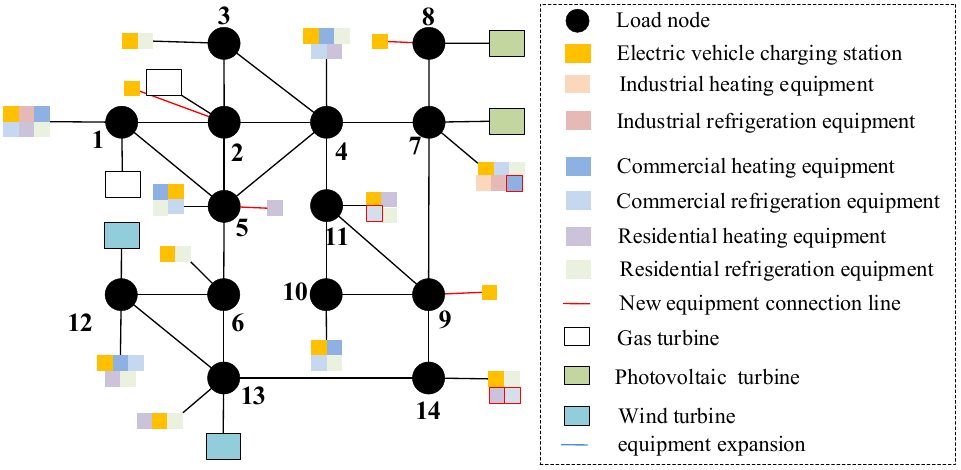
Figure 22. Morphological evolution of distribution network in 2028. Table 2. Optimal allocation results of distribution network resources from 2025 to 2030. Table 1. Resource allocation results of distribution network from 2020 to